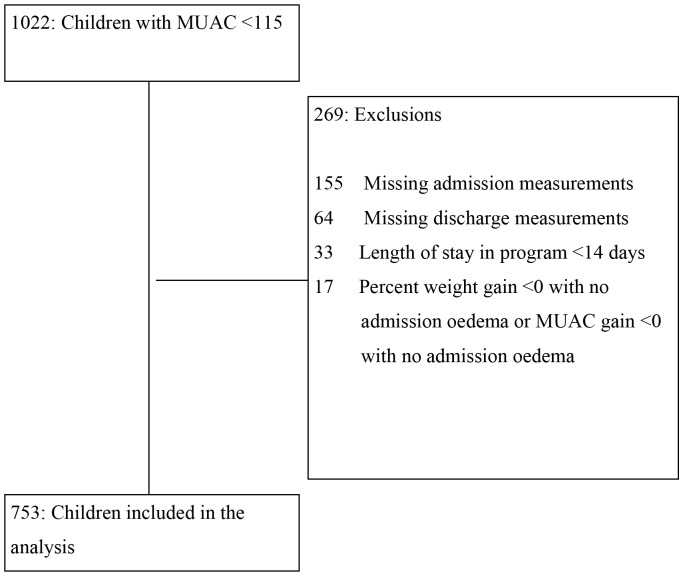
Flowchart of Outpatient Therapeutic Program children excluded from analysis.